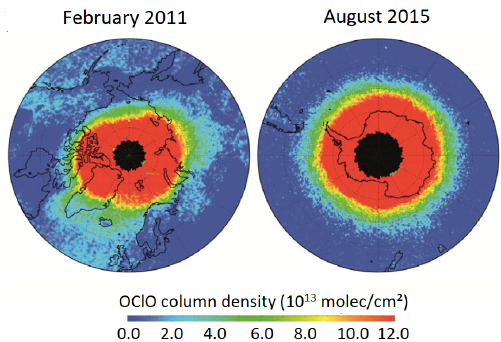
Figure 1. GOME-2 OClO SCD maps for February 2011 and August